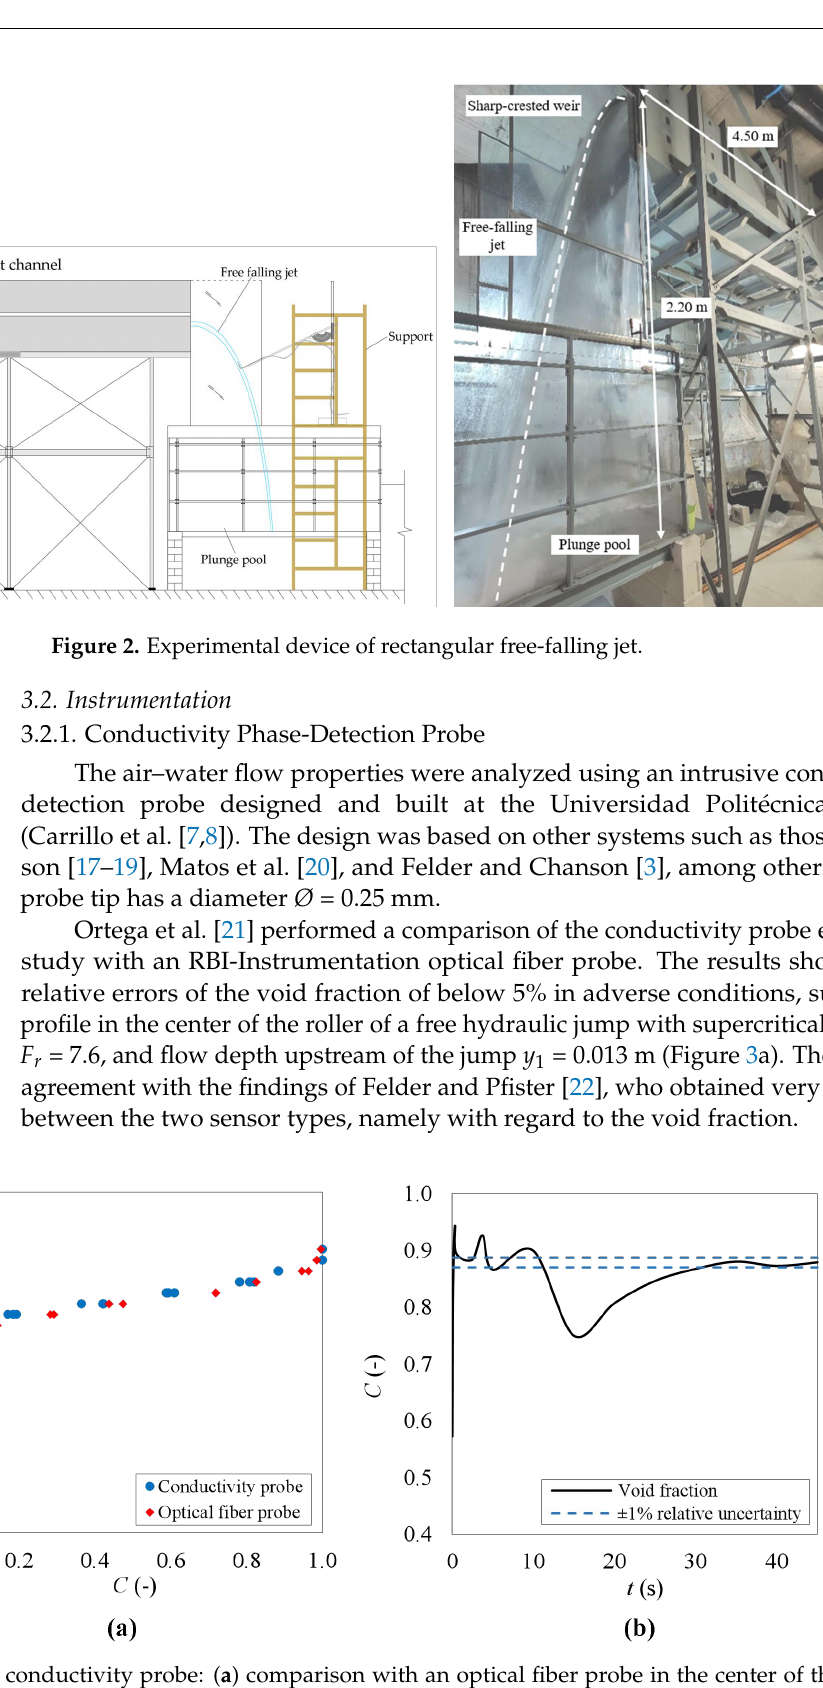
Figure 3. Analysis of the conductivity probe: ( a ) comparison with an optical fiber probe in the center of the roller of a hydraulic jump with F r = 7.6 (adapted from Ortega et al. [21]); ( b ) evolution of the void fraction during a sampling test.